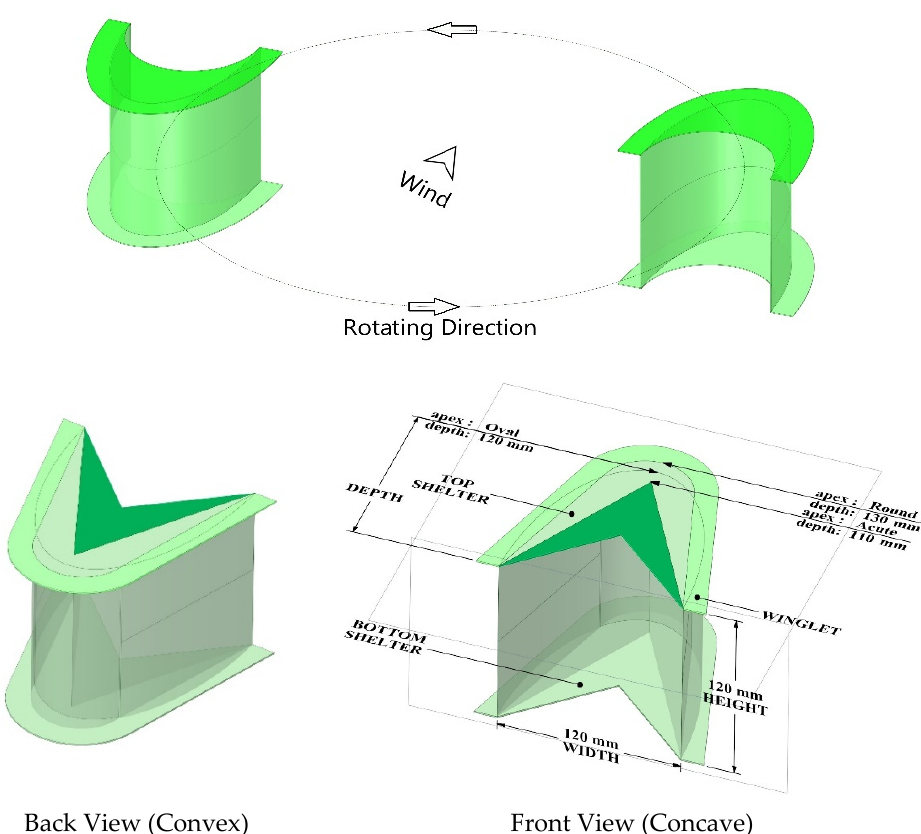
Figure 3. Conceptual design of Novel Blade profile.